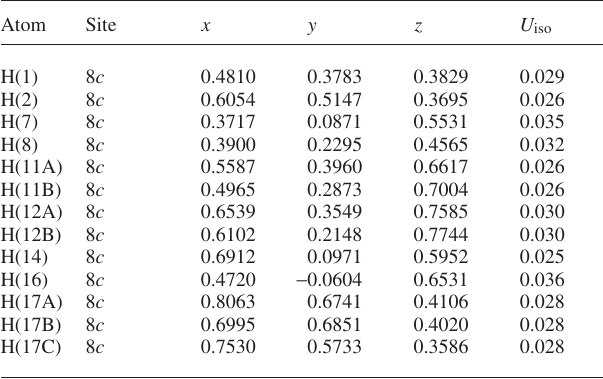
Table 2. Atomic coordinates and displacement parameters (in Å 2 )